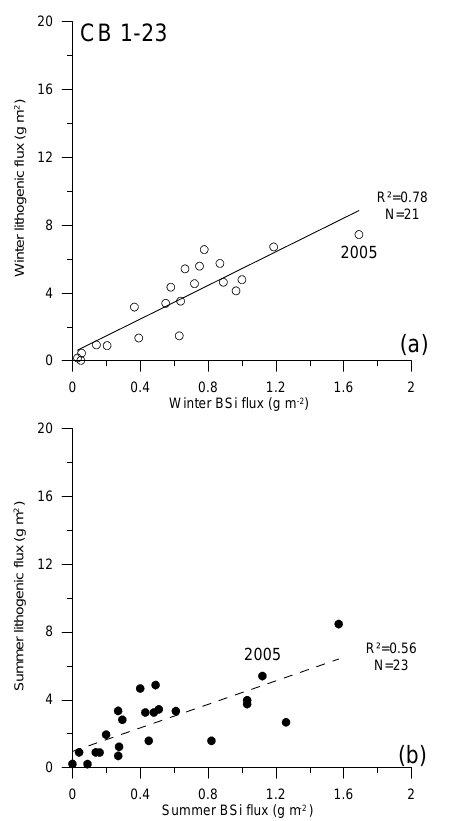
Figure 9. Relationships between BSi and lithogenic ( = mineral dust) fluxes for the winter (a) and summer (b) seasons. Note the high correspondence in winter ( R 2 = 0.78, N = 21); a lower coeffi- cient is found for the summer season. During the outstanding year of 2005 (see Fig. 7), both points for winter and summer are close to the linear regression line.